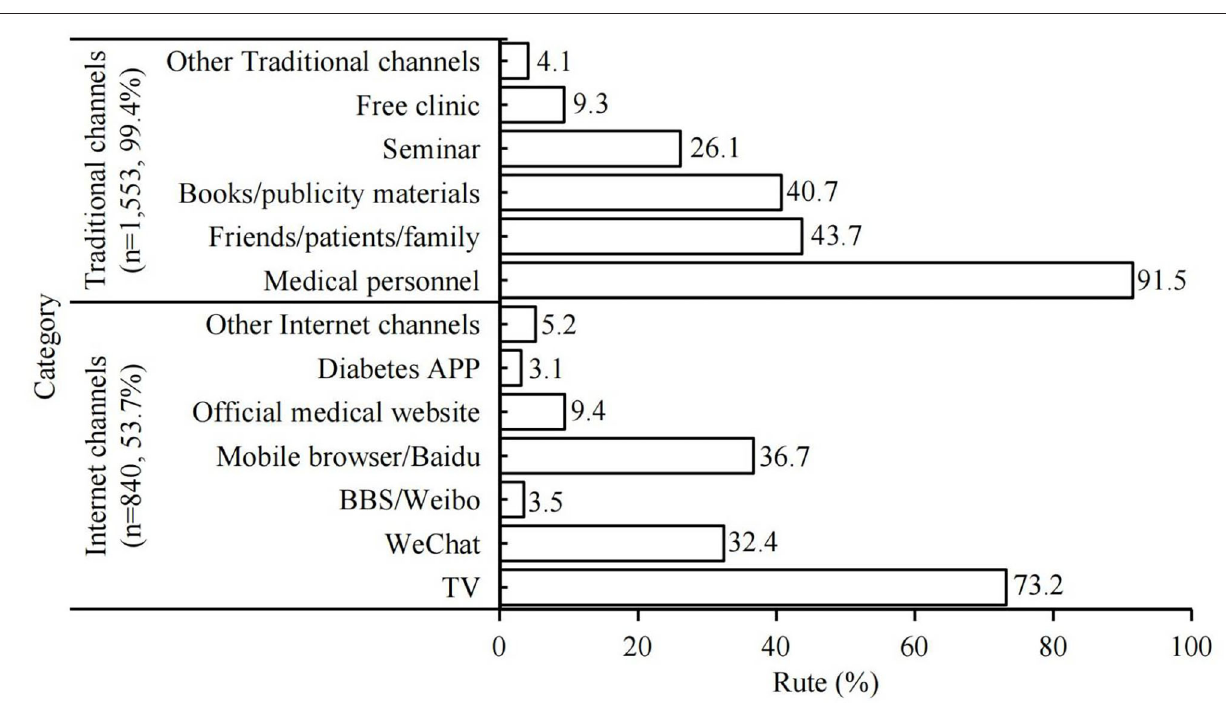
FIGURE 3 | Current status of access to health information for the